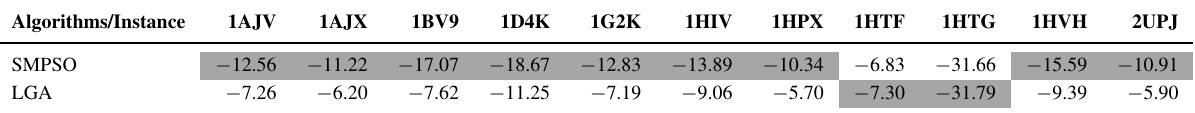
Table 3. Best binding energy values (kcal/mol) calculated from all SMPSO solutions in comparison with the best values of LGA mono-objective solutions. The grey background represents the best solutions in terms of binding